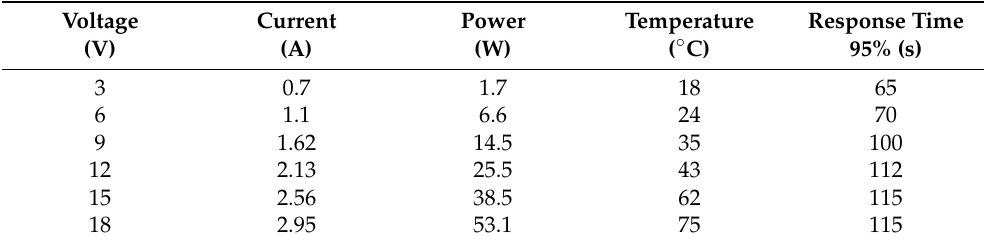
Figure 17. Thermal behavior under different applied input voltages: ( a ) time evolution of temperature behavior and ( b ) temperature (blue curve) and electrical power (orange curve) versus input voltage. Dotted lines represent the quadratic models. Table 11. Electrical power and temperature in the steady state were obtained with different input voltage levels. The response times during which the system reaches 95% of the steady temperature are also provided.